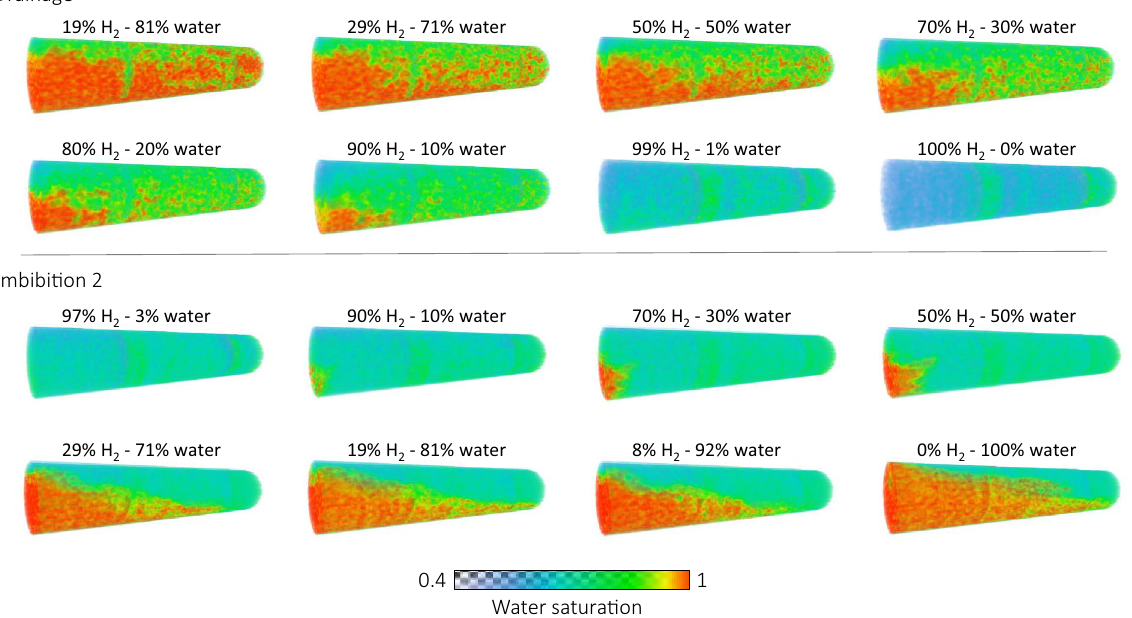
Figure 4. Steady-state water saturation maps for each step during Drainage and Imbibition 2.